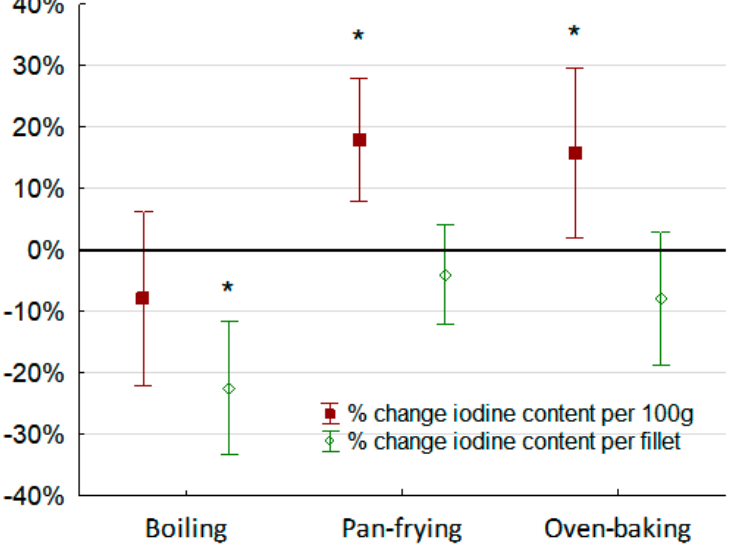
Figure 2. Percentage (%) change of iodine before and after different cooking methods (wet weight). Red bars show change in iodine content ( μ g/100 g) and green bars show change in total iodine per cod fillet ( μ g). Significant differences within cooking method are indicated by * ( p < 0.01).